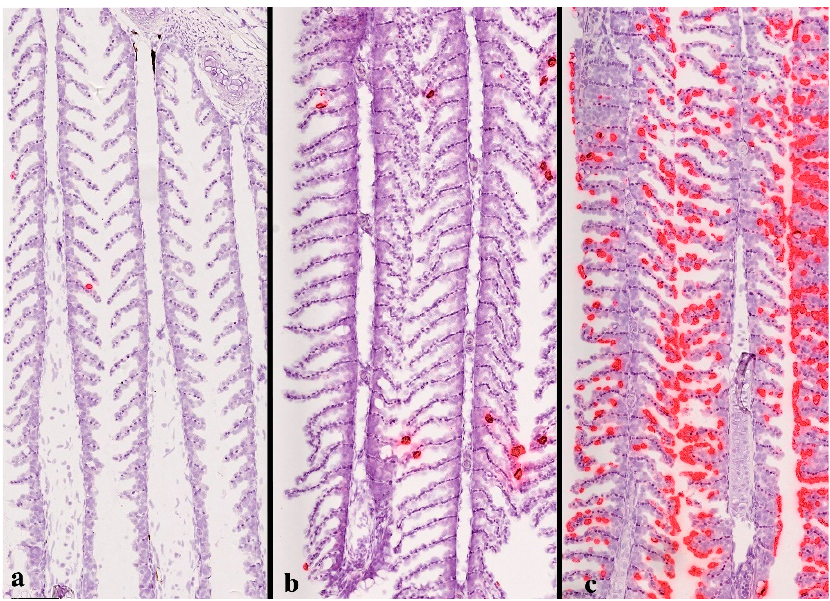
Figure 5. In situ hybridisation of SGPV D13L RNA in salmon gills infected with SGPV. Different stages of disease during an SGPV challenge experiment from ( a ) early, ( b ) mid infection course, and ( c ) at peak of fish mortality with a gradual increase in virus load (red staining). Scale bar 100 μ m. Reproduced from Thoen et al. [11].